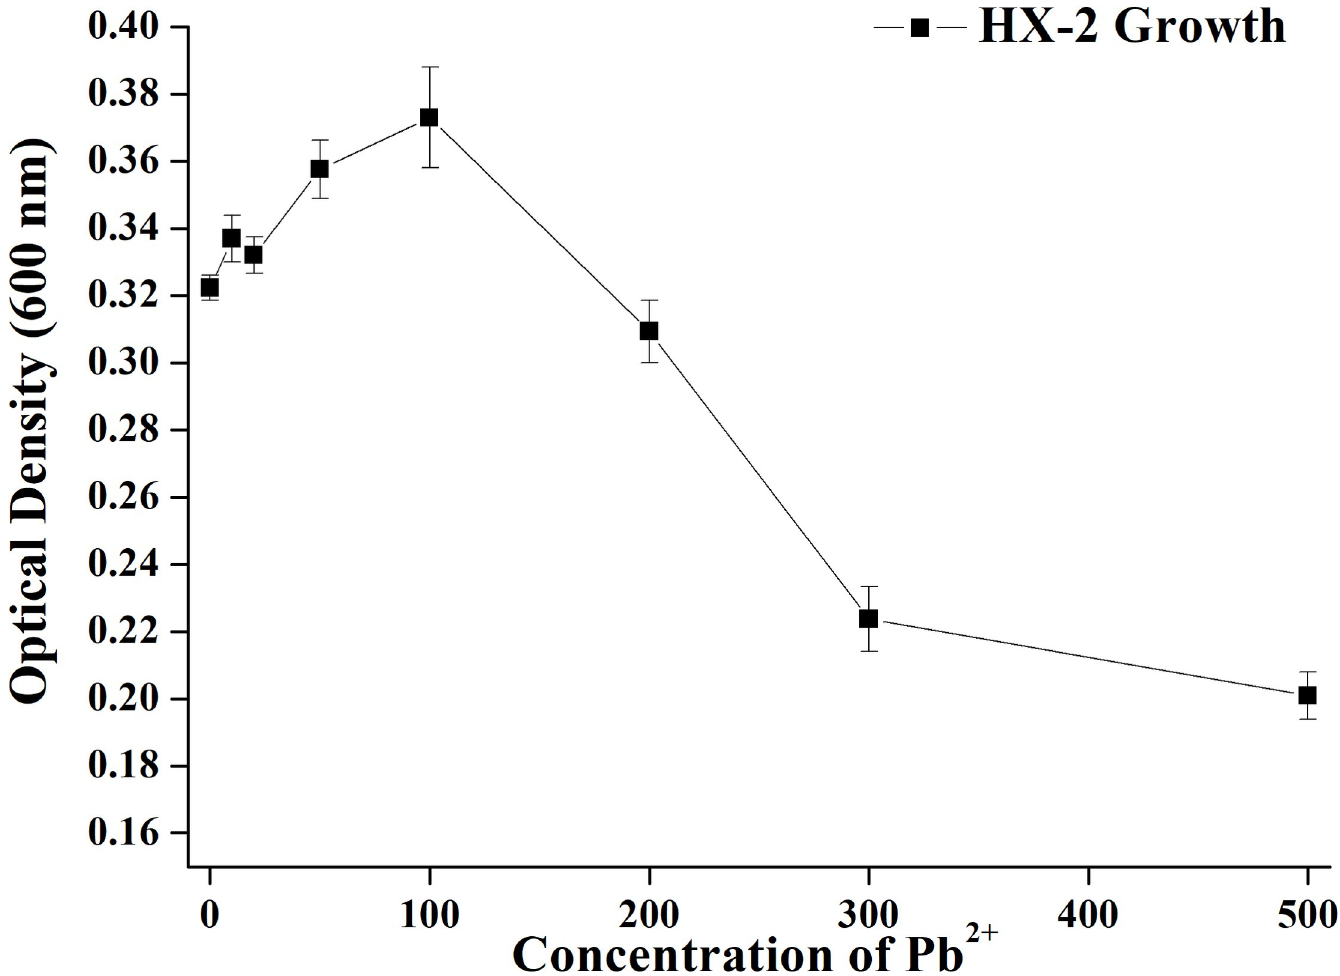
Fig 1. Effect of Pb 2+ concentrations on the growth of strain